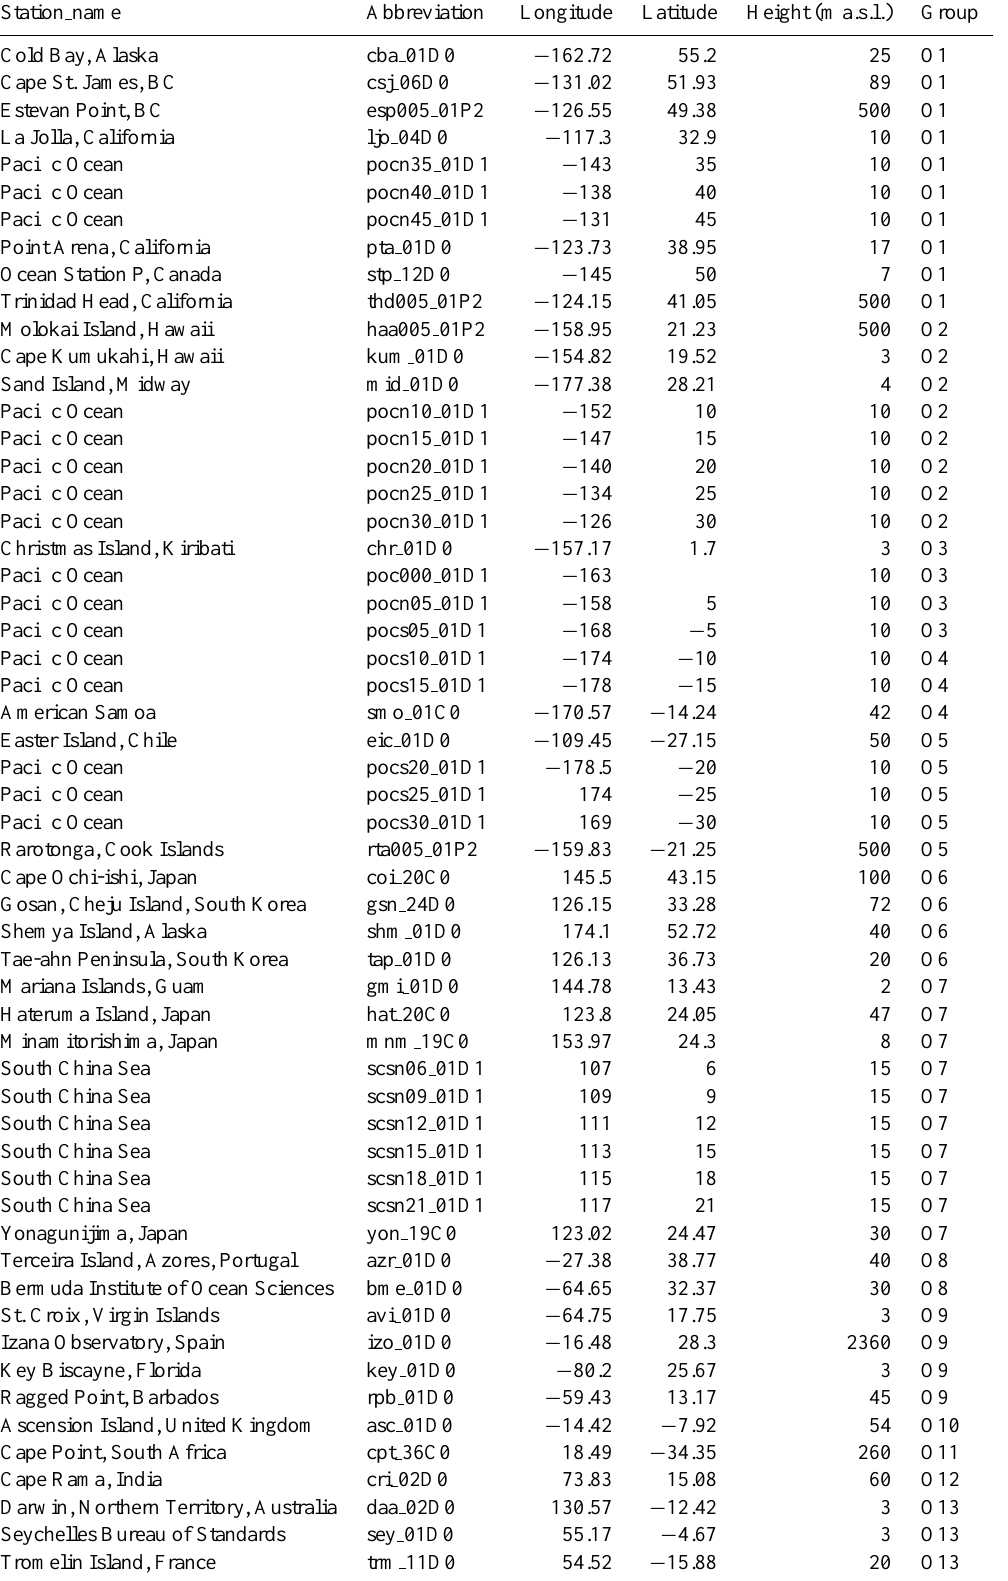
Table A1. Stations used in this